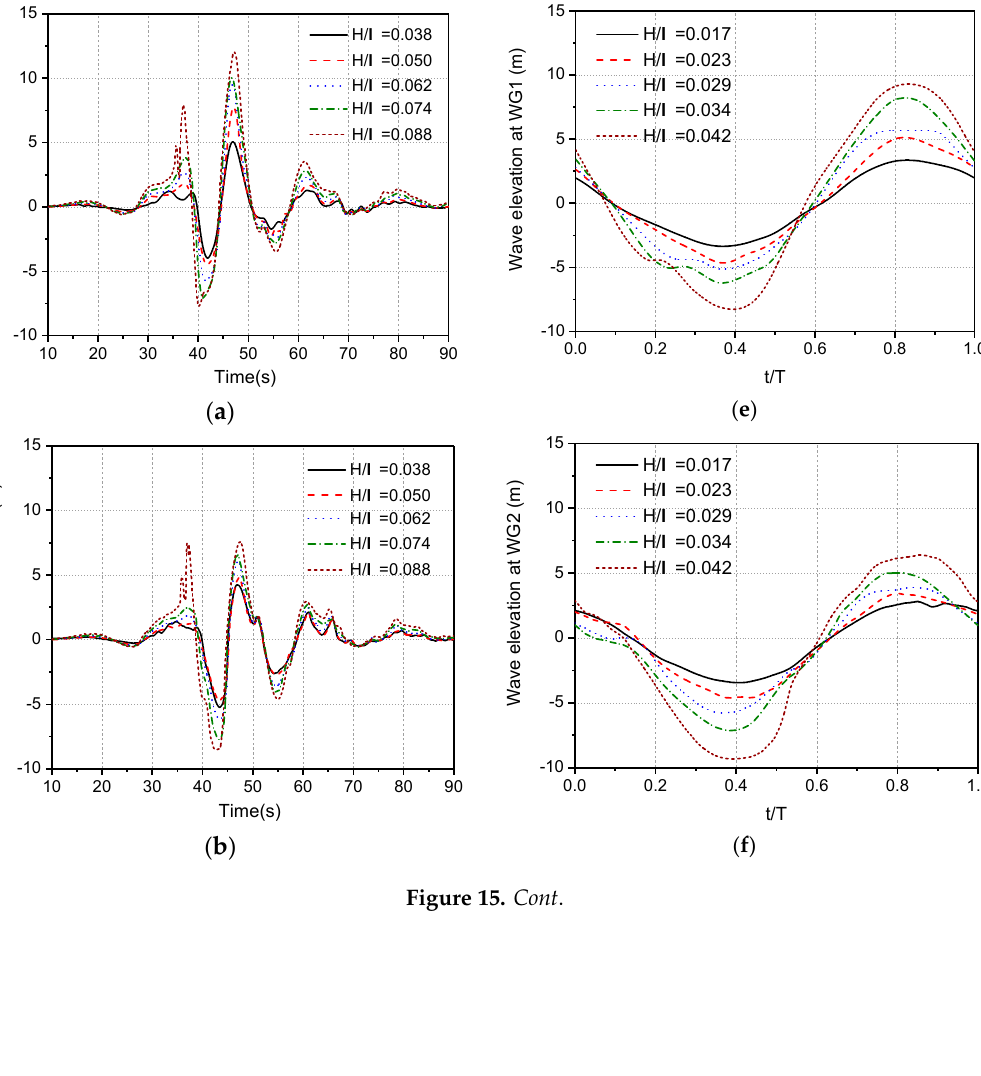
Figure 14. Sketch of wave gauge settings for a fixed semi-submersible platform.